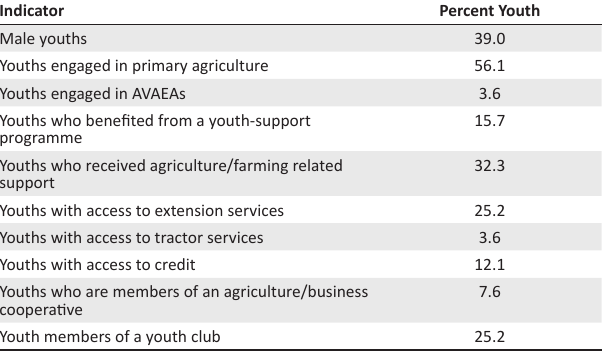
TABLE 3: Descriptive statistics of the categorical youth characteristics indicators.